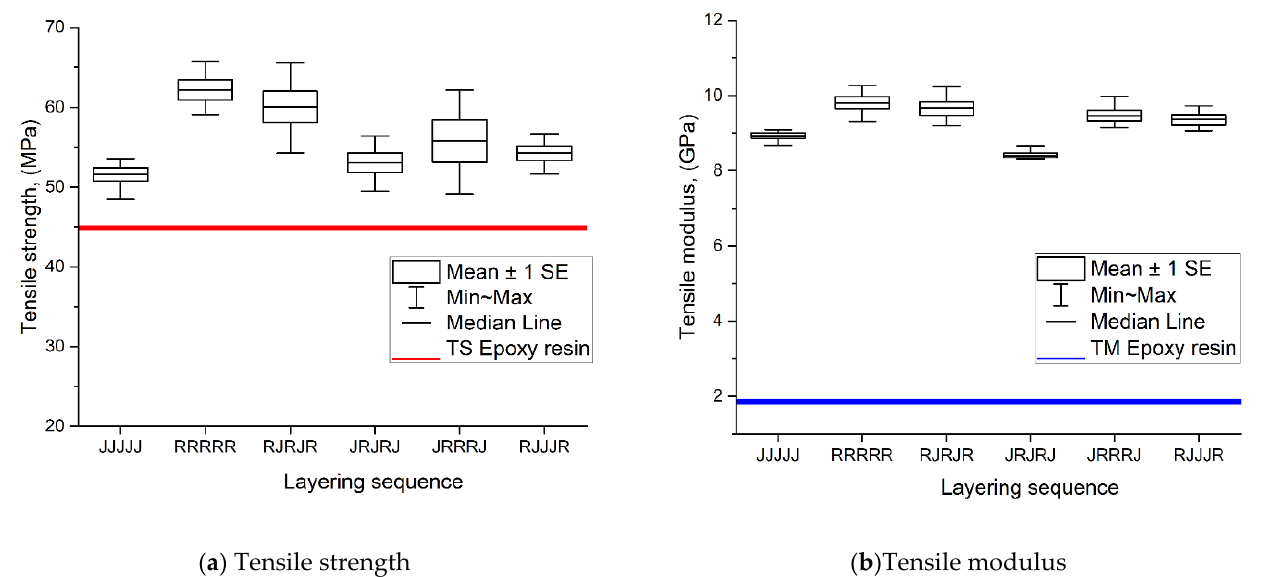
Figure 4. Tensile strength ( a ) and tensile modulus ( b ) of single and hybrid jute–ramie woven